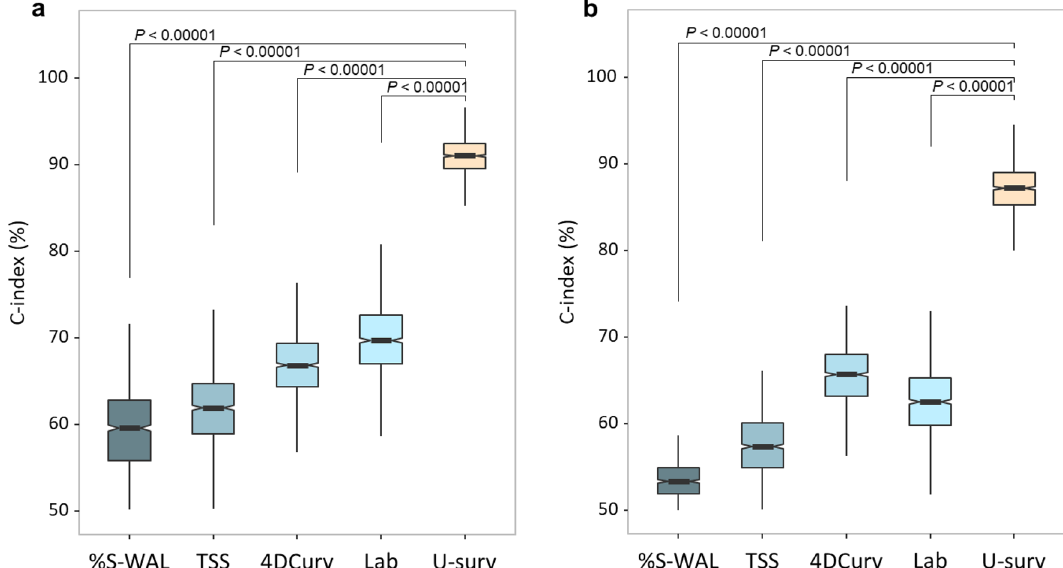
Figure 1. Performance of U-survival and the reference predictors in the prediction of COVID-19 progression and mortality for the subcohorts of patients for whom all the predictors were available. ( a , b ) Notched boxplots, in which the middle lines and the notches show the means and 95% confidence intervals, of the C-index values of U-survival and the reference predictors in the prediction of disease progression ( a ), where the outcome is defined as ICU admission or death, and in the prediction of mortality ( b ), where the outcome is defined as death. The C-index values were obtained by per-patient bootstrapping with 1000 replicates. The P values were obtained by use of a bootstrap hypothesis test. %S-WAL percentage of well-aerated lung parenchyma, TSS total severity score, 4DCurv 4D-curvature, Lab laboratory tests, U-surv